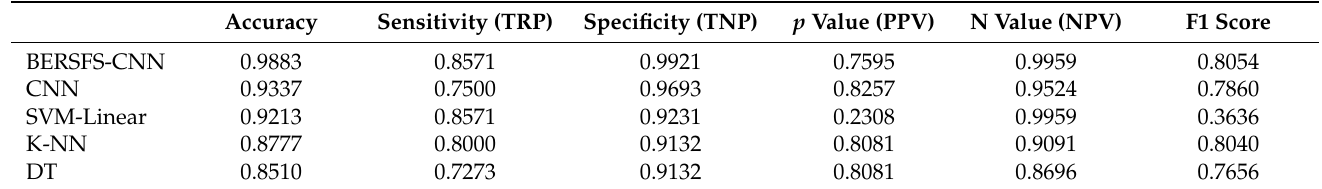
Table 4. Results of comparisons between proposed BERSFS-CNN and basic models.